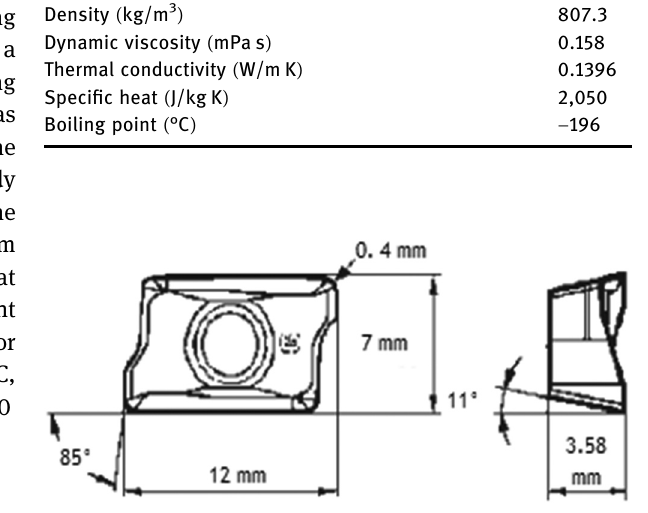
Figure 1: Schematic diagram and geometry of the cutting tool used in the